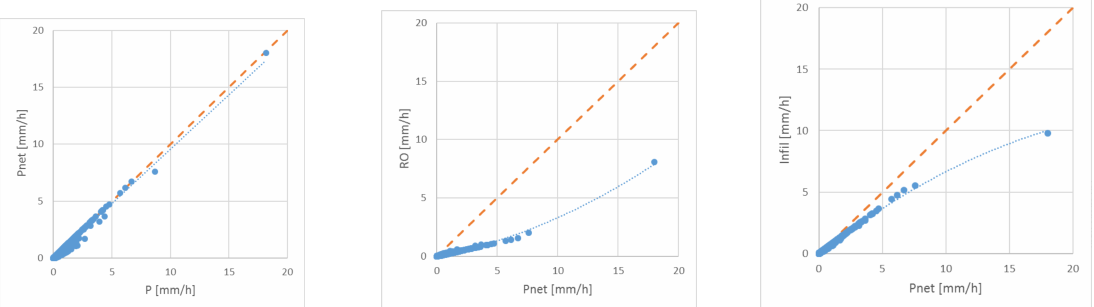
Figure 3. Scatterplots for main correlated variables (P, Pnet, RO, Infil) simulated with WetSpa as averages over the whole WMB catchment. P and Pnet show a linear correlation whereas Pnet shows a polynomial correlation with RO and